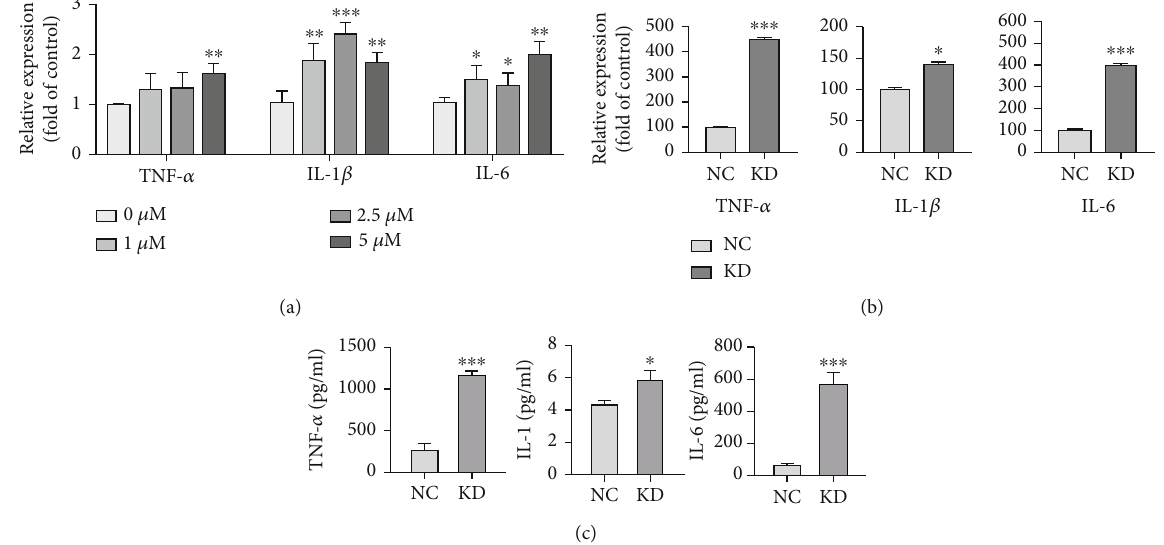
Figure 4: REST repressed proin fl ammation cytokine TNF- α , IL-1 β , and IL-6 expression and secretion. (a) A β cytokine TNF- α , IL-1 β , and IL-6 upregulation and anti-in fl ammation cytokine IL-12 downregulation. (b) Knockdown REST gene induced proin fl ammation cytokine TNF- α , IL-1 β , and IL-6 mRNA upregulation with the treatment of A β increased secretion of proin fl ammation cytokines TNF- α , IL-1 β , and IL-6. ∗ P < 0 : 05 vs. control, ∗∗ P < 0 : 01 vs. control, and ∗∗∗ P < 0 : 001 vs.